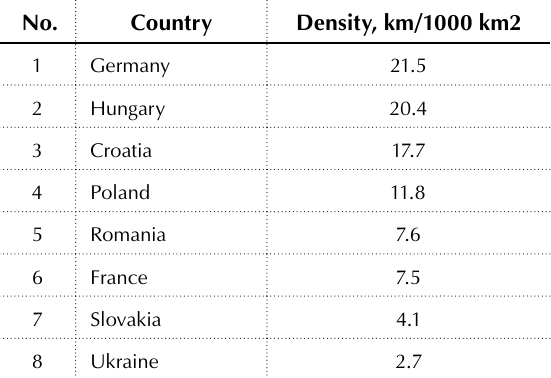
Table 2. Density of river shipping routes of European countries , 2015